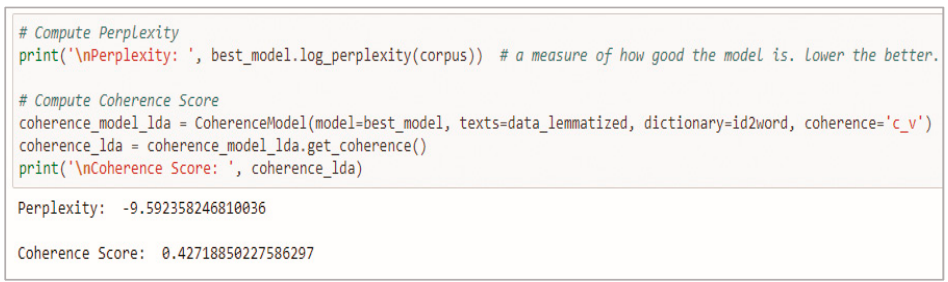
Mathematics 2023 , 11 , x FOR PEER REVIEW Figure 6. Selected major topics discovered. Figure 6. Selected major topics discovered.